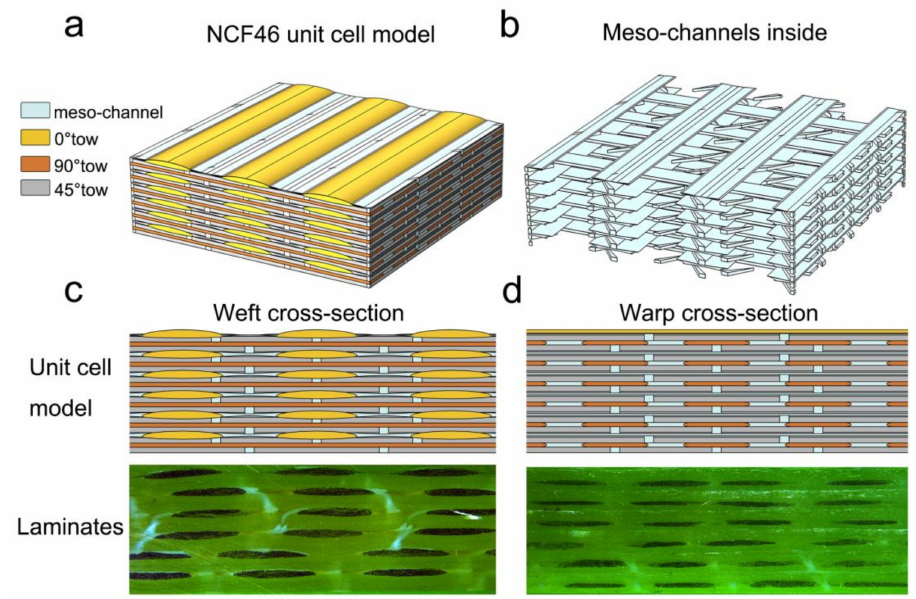
Figure 9. ( a ) Unit cell model of six layers of quadriaxial NCF fabric; ( b ) meso-channel networks inside the unit cell model; ( c ) comparison of cross-sections between the unit cell model and the laminate along warp direction; ( d ) comparison of cross-sections between the unit cell model and the laminate along weft